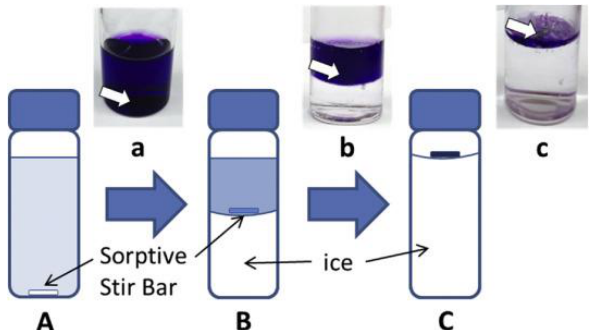
Figure 3. Scheme of ice concentration linked with the extractive stirrer technique. The stirrer is located in the bottom of the vial ( A ) which is cooled down. As a consequence, ice is created ( B and C ) leaving a more concentrated solution than the original sample. The pictures show the extraction of methyl violet as the model analyte: ( a ) initial state, ( b ) extraction and ( c ) final state. Reproduced with permission from [28], copyright Elsevier, 2016.